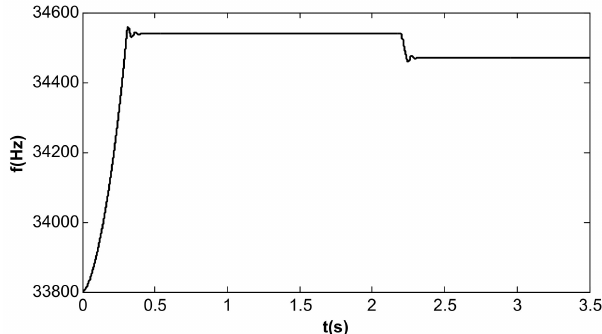
Figure 12. Frequency tracking control under single closed loop ( k II = 2).